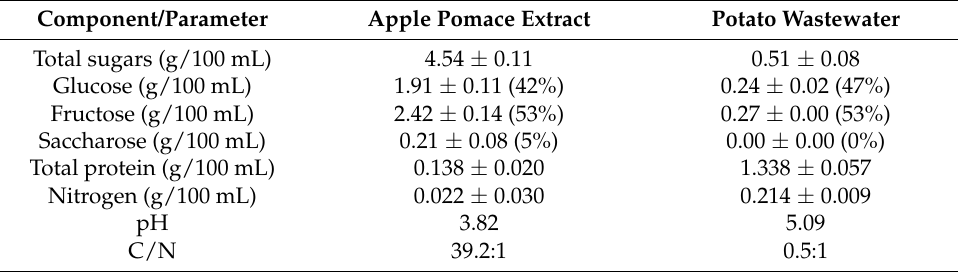
Table 1. Characteristics of waste